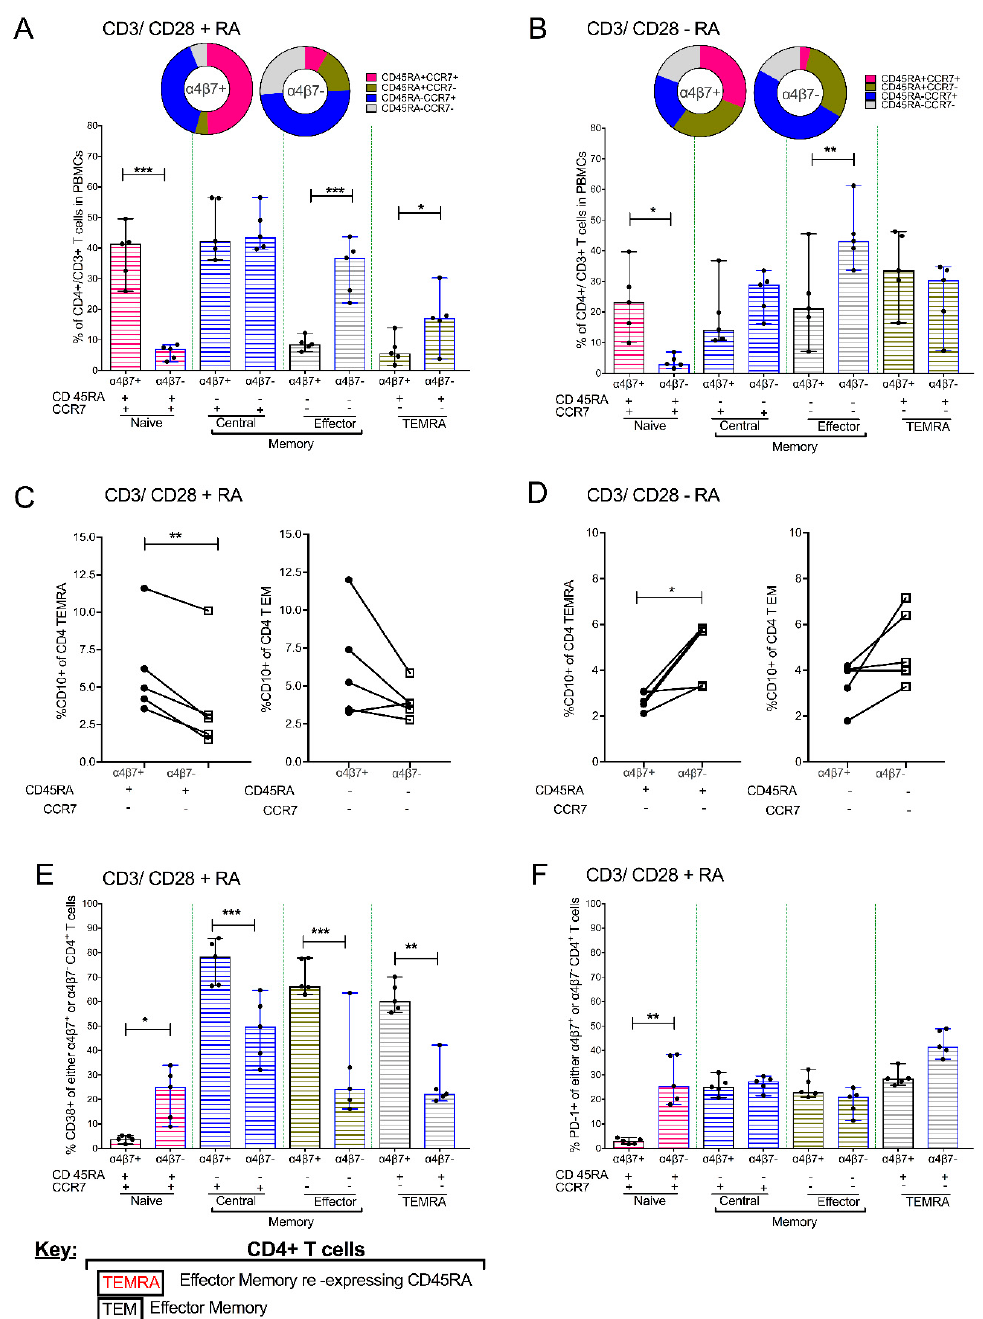
Figure 4. Addition of 1uM RA to PBMCs that were previously activated with anti-CD3/CD28 beads and cultured in IL-2 enriched media leads to different memory/differentiation profiles in α 4 β 7 + vs. α 4 β 7 − CD4 + T cells ( n = 5). Combined bar graph and pie chart showing the comparative distribution of naive, central memory, effector memory (EM) and terminal effector memory cells re-expressing CD45RA (TEMRA) subsets within α 4 β 7 + vs. α 4 β 7 − CD4+ T cells obtained from PBMC treated with ( A ) CD3/CD28 beads + RA or ( B ) CD3/CD28 beads - RA. ( C ) Dot plots indicating paired comparisons for the quantification of CD10+ levels in α 4 β 7 + vs. α 4 β 7 − partitions of CD4 + TEMRA cells and CD4 + TEM cells in CD3/CD28 + RA or ( D ) CD3/CD28 − RA treatment conditions. ( E ) The distribution of CD38 and ( F ) PD-1 markers of immune activation amongst CD4 + T cell subsets obtained from PBMC treated with CD3/CD28 beads + RA conditions. * shows p < 0.05, ** indicates p < 0.001 while *** denotes p < 0.0001 obtained using Wilcoxon matched pairs signed rank tests.